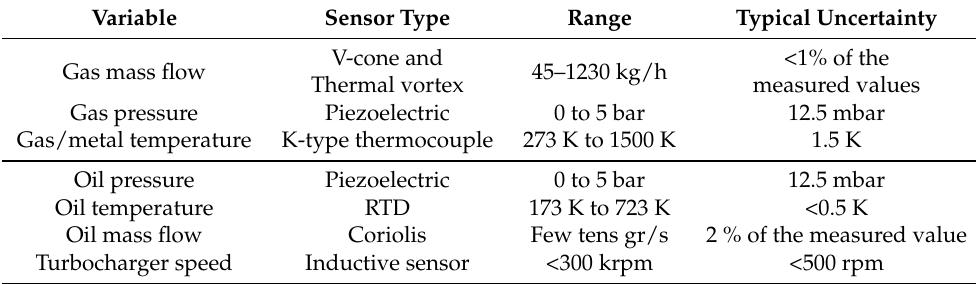
Figure 3. Gas stand for testing the double entry turbines at different flow admission conditions in steady flow situations. Table 1. List of main sensors used in the experimental work, showing their typical